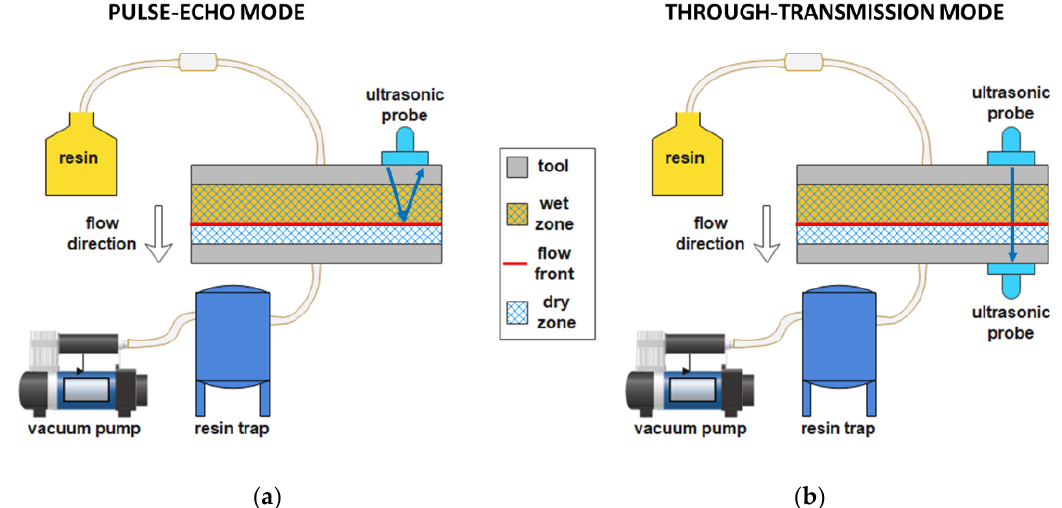
Figure 7. Experimental set-up for out-of-plane permeability measurement by ultrasonic wave propagation with ( a ) pulse-echo mode or ( b ) through-transmission mode.